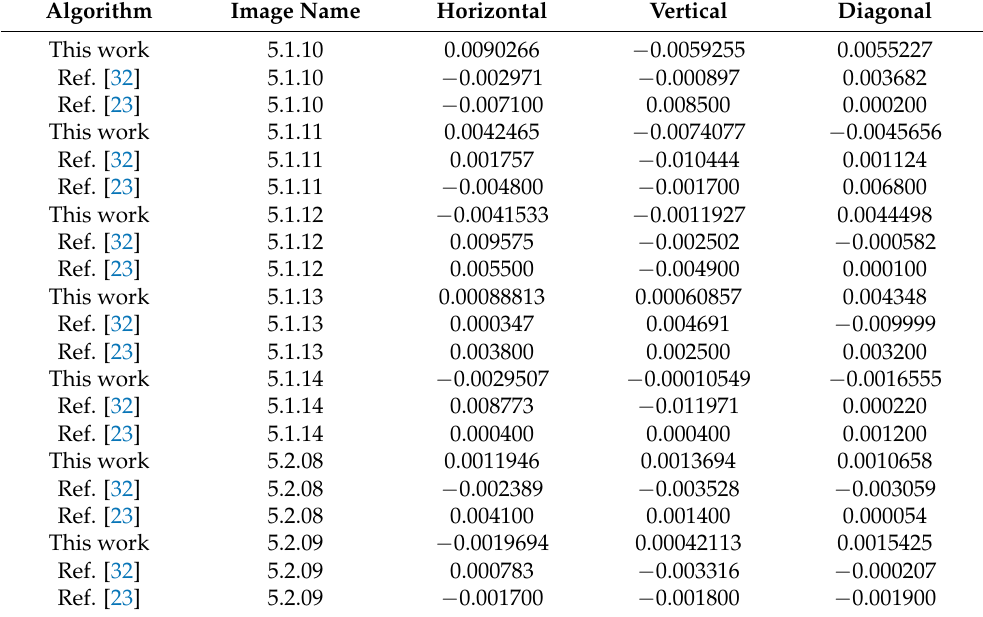
Table 4. Correlation coefficients of cipher images encrypted by different